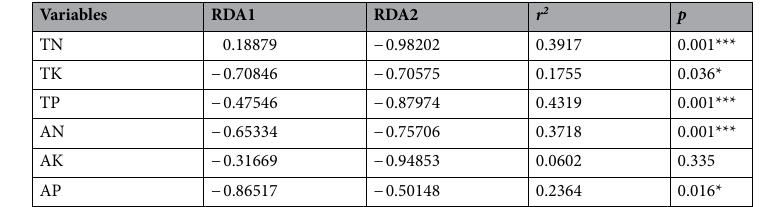
Table 3. Correlations between environmental variables and rhizosphere prokaryotic composition (OTU level) assessed by the Monte Carlo permutation test (999 permutations) for canonical correspondence